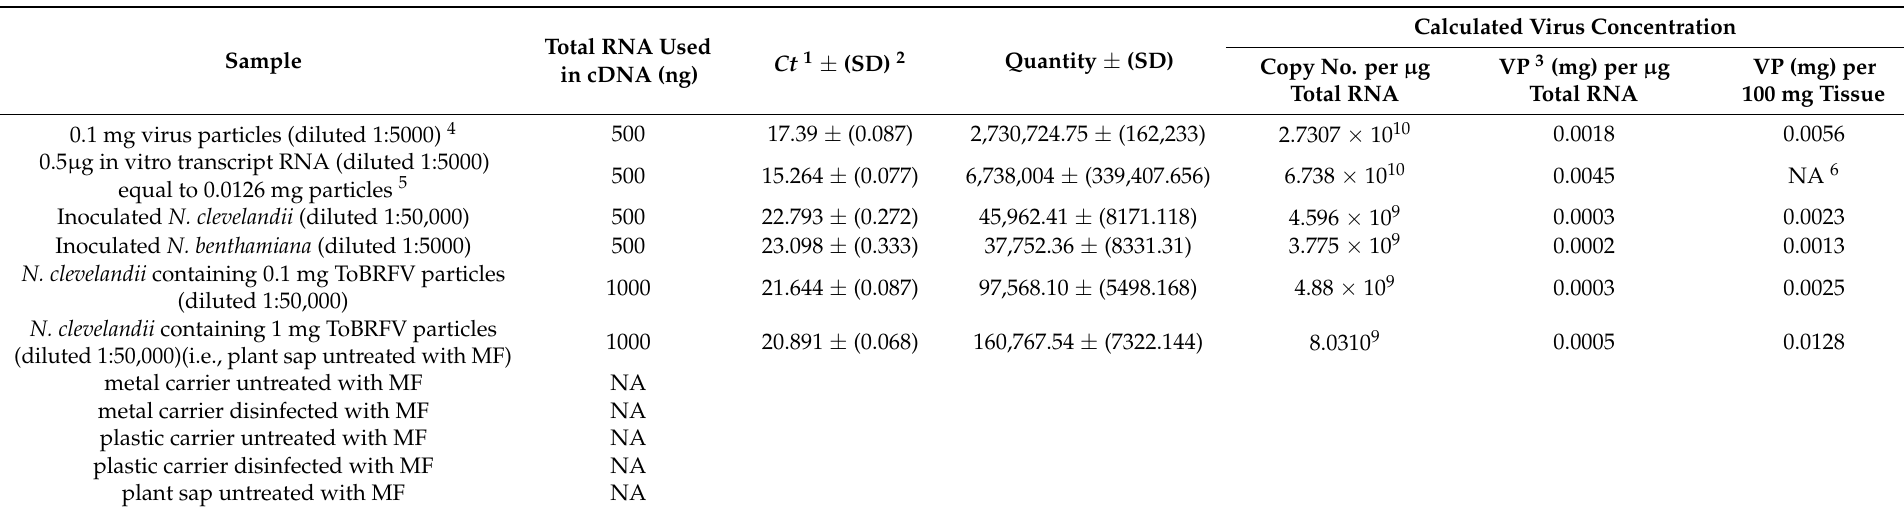
Table 4. Overview of estimated ToBRFV load using absolute RT-qPCR with TaqMan probe depended on treatment with the disinfectant MENNO Florades